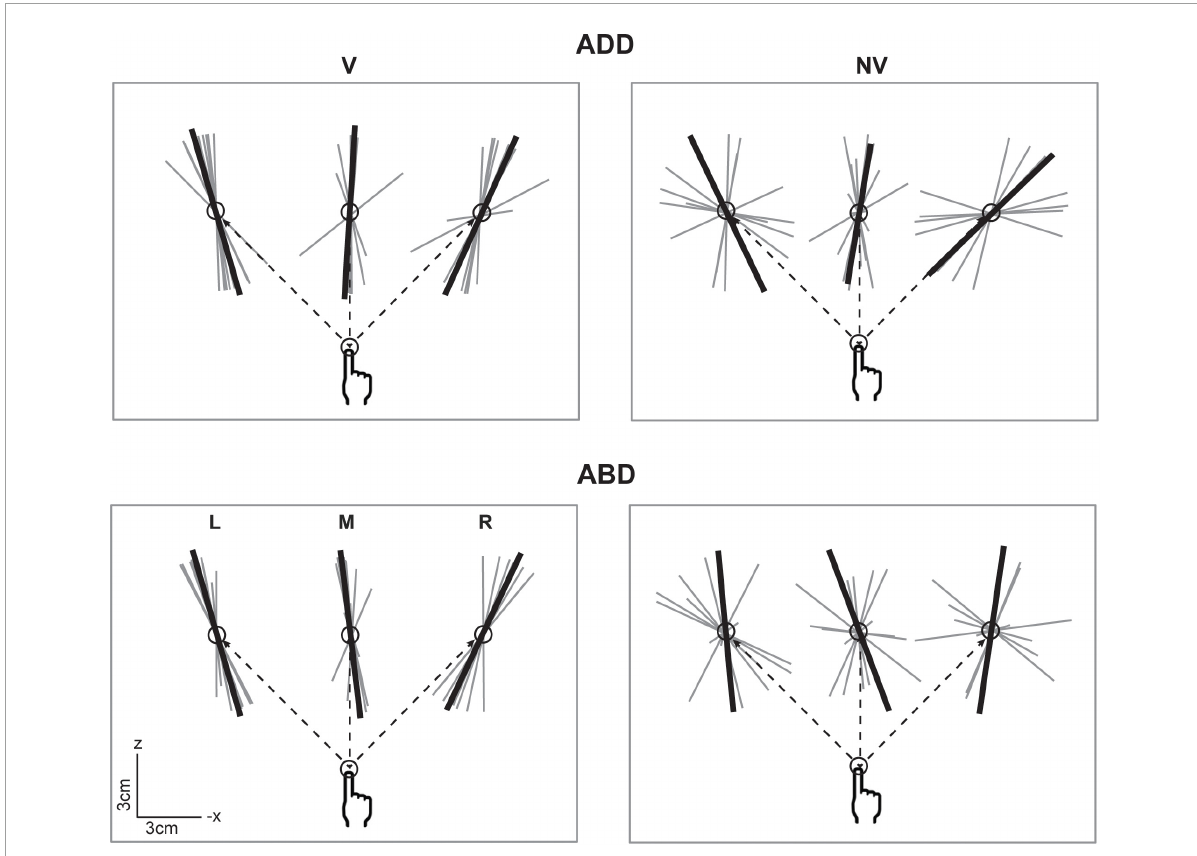
FIGURE5 Top-down view of the individual (gray) and average (black) principal axes of variability in the V condition. Axes were scaled to an arbitrary length for visualization purposes. Dashed lines show the straight-line paths to each target. Average axes were more convergent toward the starting hand position in the V condition than in the NV condition. In the V condition, the average axis for the middle target demonstrated a small counter clockwise rotation as initial arm posture changed from ADD to ABD. A larger magnitude rotation in the same direction was also observed for this target in the NV condition, as well as for the right